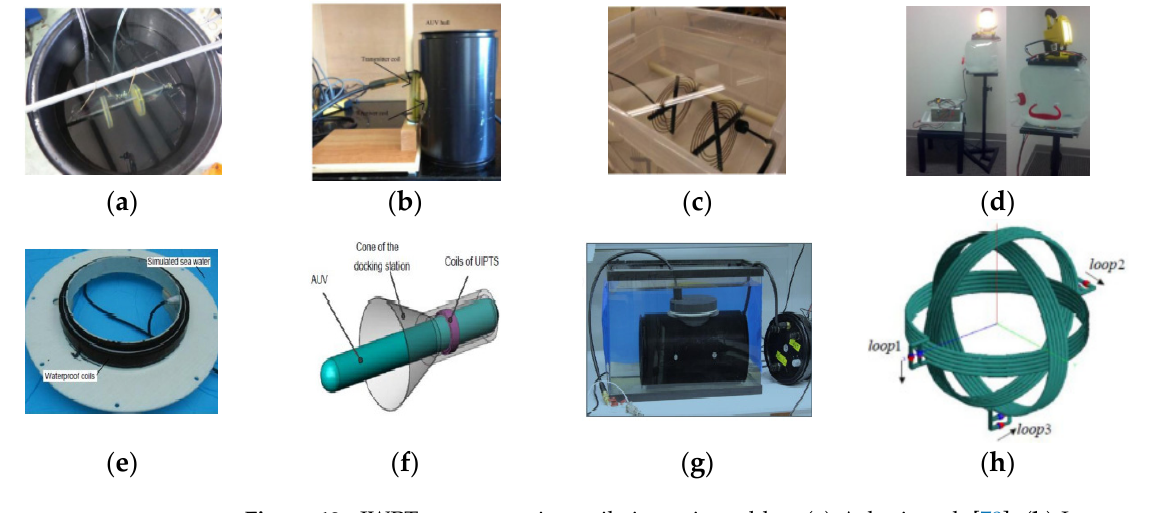
Figure 12. IWPT systems using coils investigated by: ( a ) Askari et al. [78]; ( b ) James et al. [79]; ( c ) Santos et al. [82]; ( d ) WiTricity [80]; ( e , f ) Shi et al. [83]; ( g ) Bana et al. [85]; and ( h ) He et al. [100].